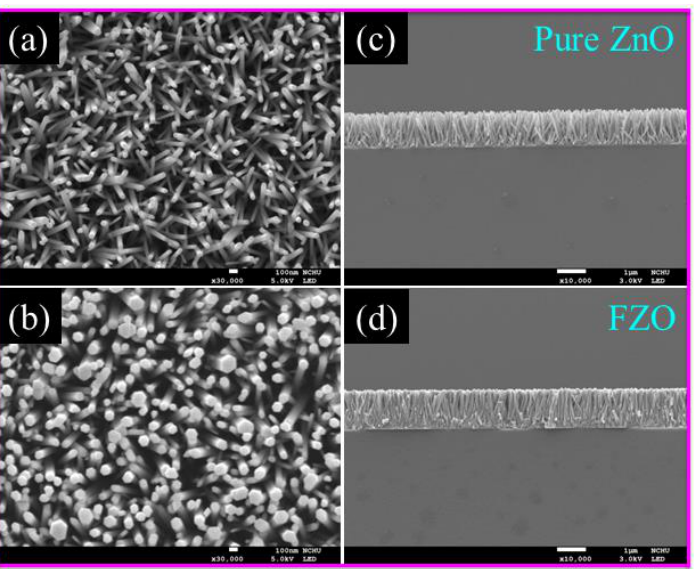
Figure 2. FE-SEM ( a , b ) top view and ( c , d ) cross-sectional micrographs of ZnO NR arrays prepared via the aqueous solution method with and without Fe content.